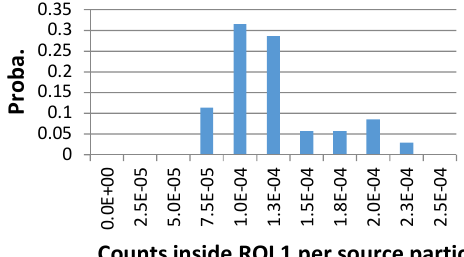
Fig. 10. Distribution of the counts in ROI 1 for HEU source simulation. In the case of the HEU source, most of the gamma-rays are emitted below 300 keV. Hence, only ROI 1 is